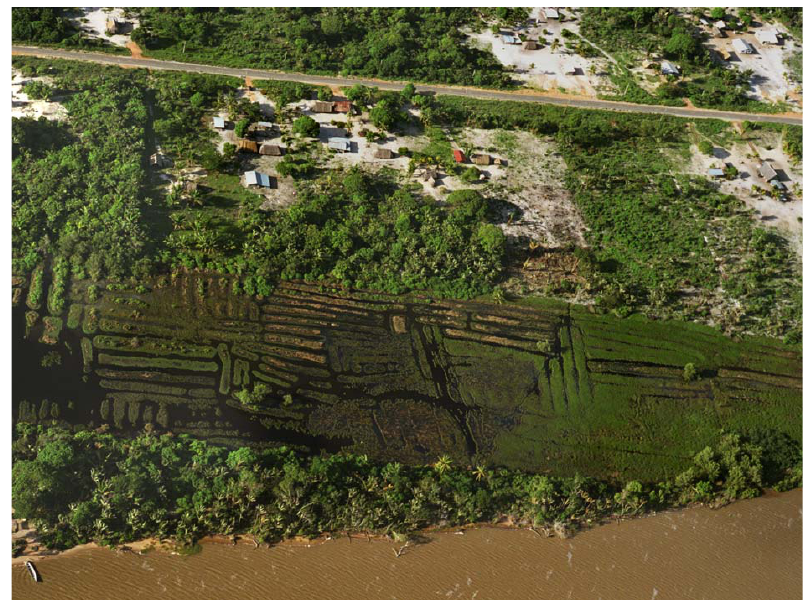
Figure 4. Raised-field complex of Piliwa near Awala, western French Guiana showing the mound distribution in a